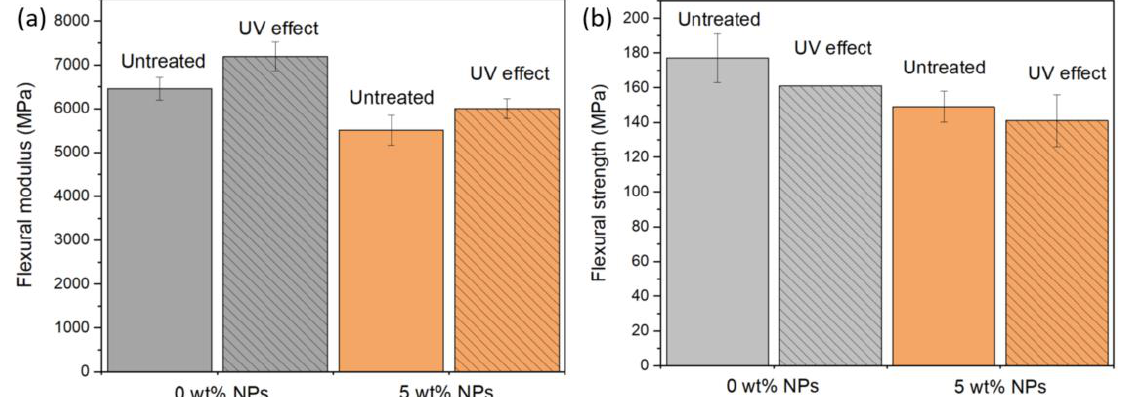
Figure 6. Effect of UV exposure on the ( a ) flexural modulus and ( b ) flexural strength of different samples.